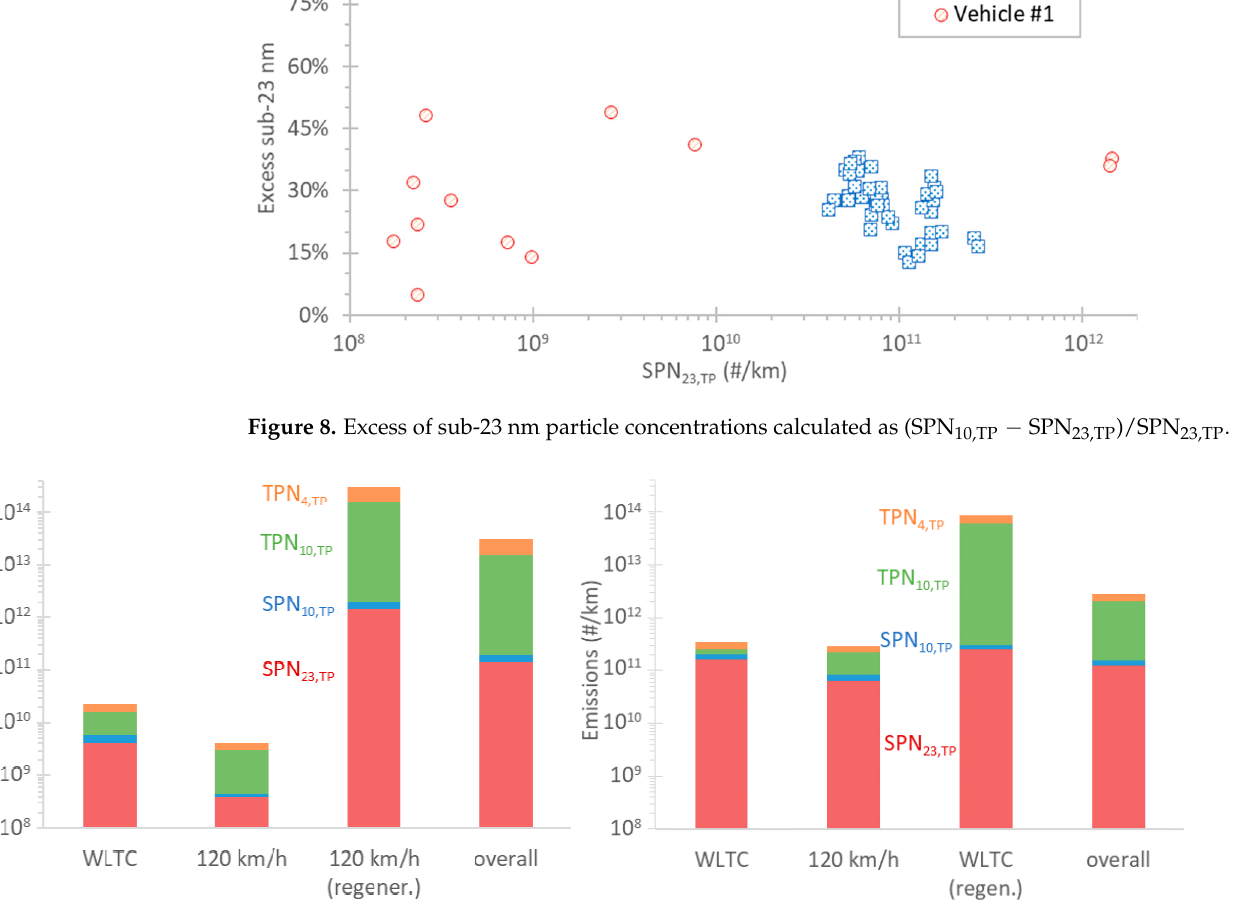
Figure 8. Excess of sub-23 nm particle concentrations calculated as (SPN 10,TP − SPN 23,TP )/SPN 23,TP .